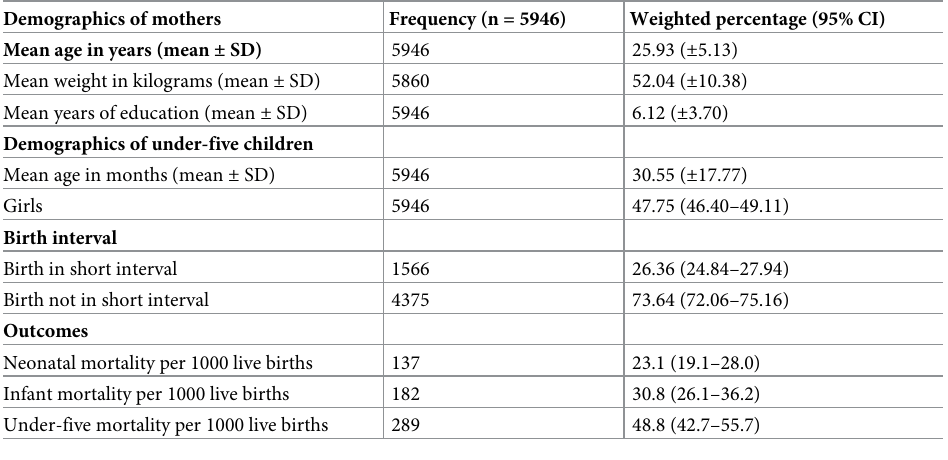
Table 1. Key information about the study participants, exposure, and outcome